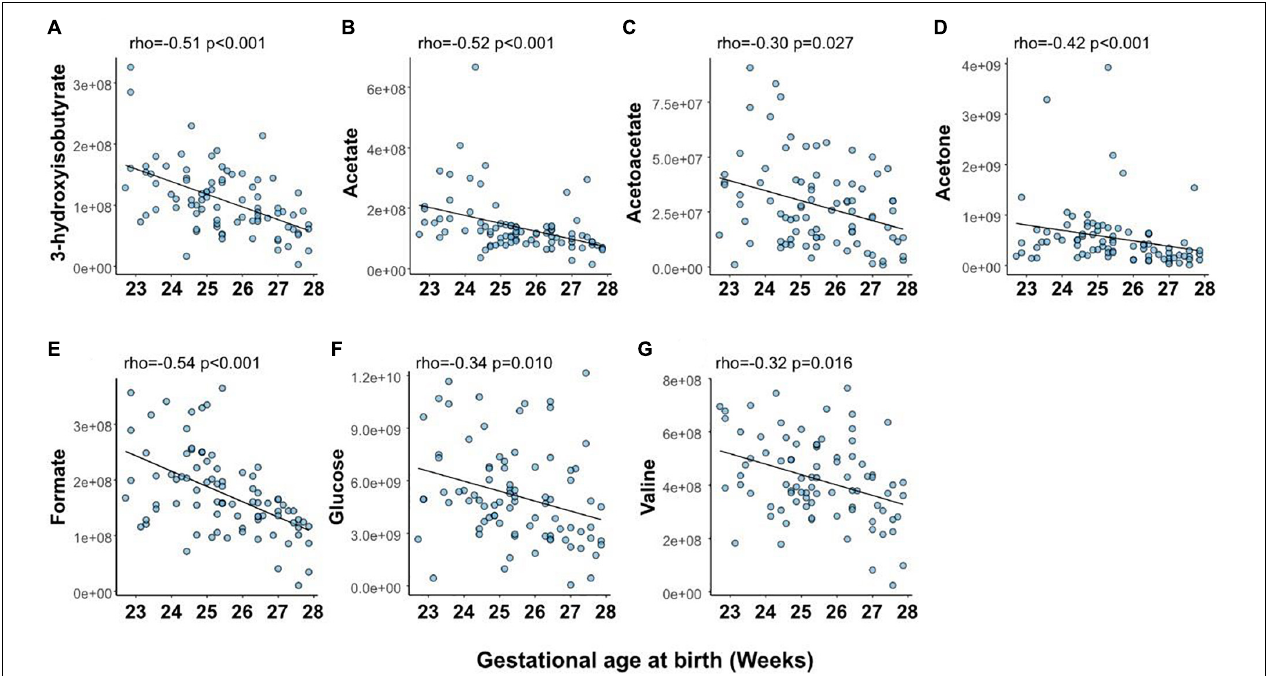
FIGURE 3 | Relationship between gestational age at birth and serum levels of metabolites at postnatal day (PND) 1: 3-hydroxyisobutyrate (A) , acetate (B) , acetoacetate (C) , acetone (D) , formate (E) , glucose (F) , and valine (G) . Shown are Spearman’s correlation coefficient (rho) and p -value for the association between metabolite levels and gestational age. p -values have been false discovery rate adjusted using the Benjamini-Hochberg method. Y -axis shows normalized NMR